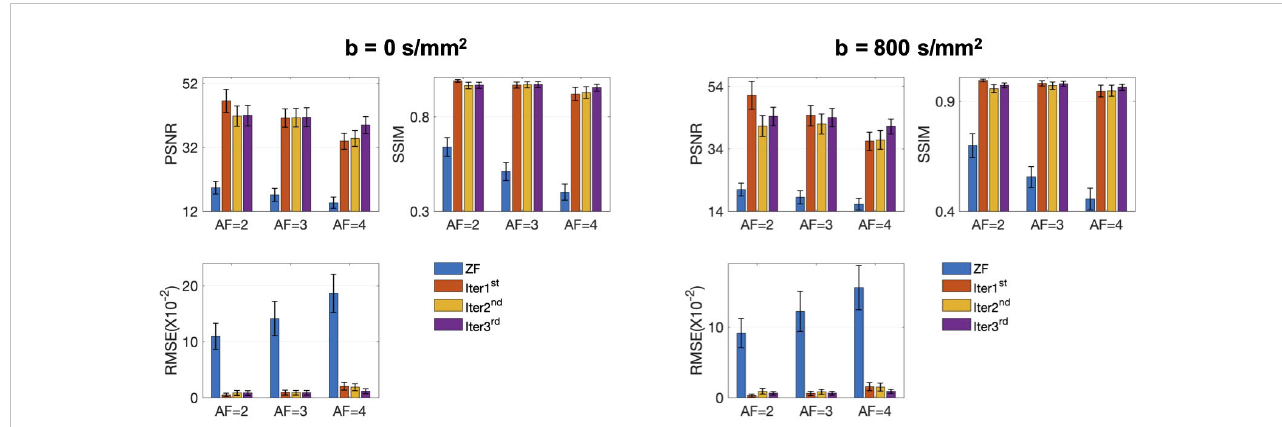
FIGURE 10 The quantitative metrics were calculated on the ZF, Iter 1st, Iter 2nd, and Iter 3rd reconstructions at different AFs. The error bars on each series indicate the standard deviation of each quantitative